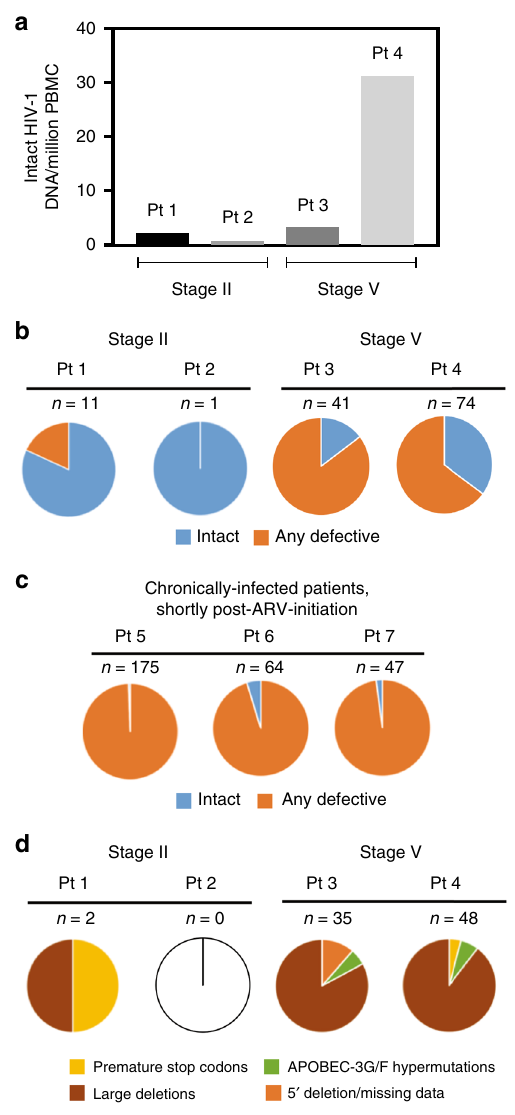
Fig. 3 Cross-sectional analysis of HIV-1 DNA sequences at stage II versus stage V of acute infections. a Absolute frequencies of intact viral genomes detected per million PBMC in indicated study patients at the earliest sampling time points. b Proportions of intact (blue) and defective (orange) viral genomes at the earliest sampling time points available from each of the four FRESH cohort participants. c Proportions of intact (blue) and defective (orange) viral genomes from three chronically-infected individuals who were sampled shortly post-therapy-initiation. d Spectrum of defective HIV-1 DNA sequences at the earliest sampling time points available from each of the four FRESH cohort participants